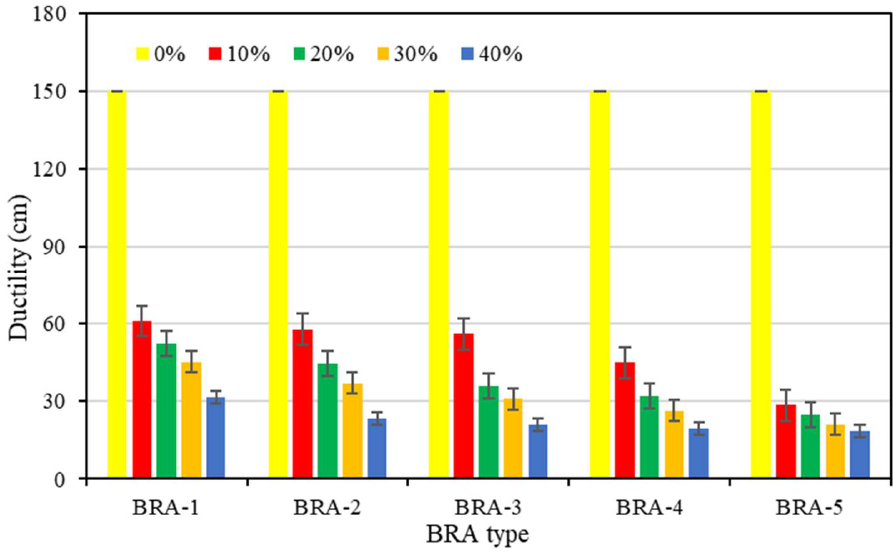
Figure 8. Ductility of base asphalt and